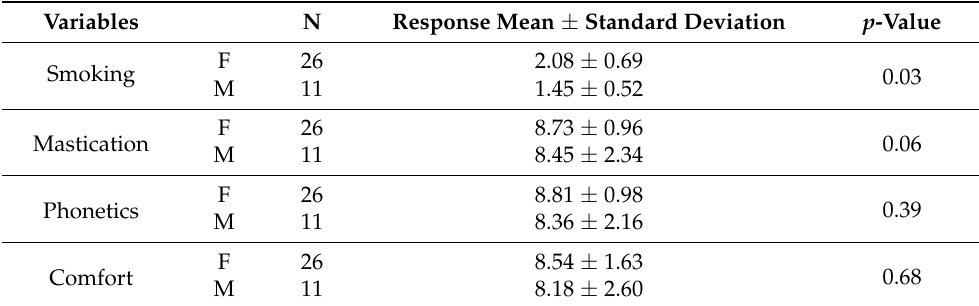
Table 4. Satisfaction among patients on responses out of 10 based on